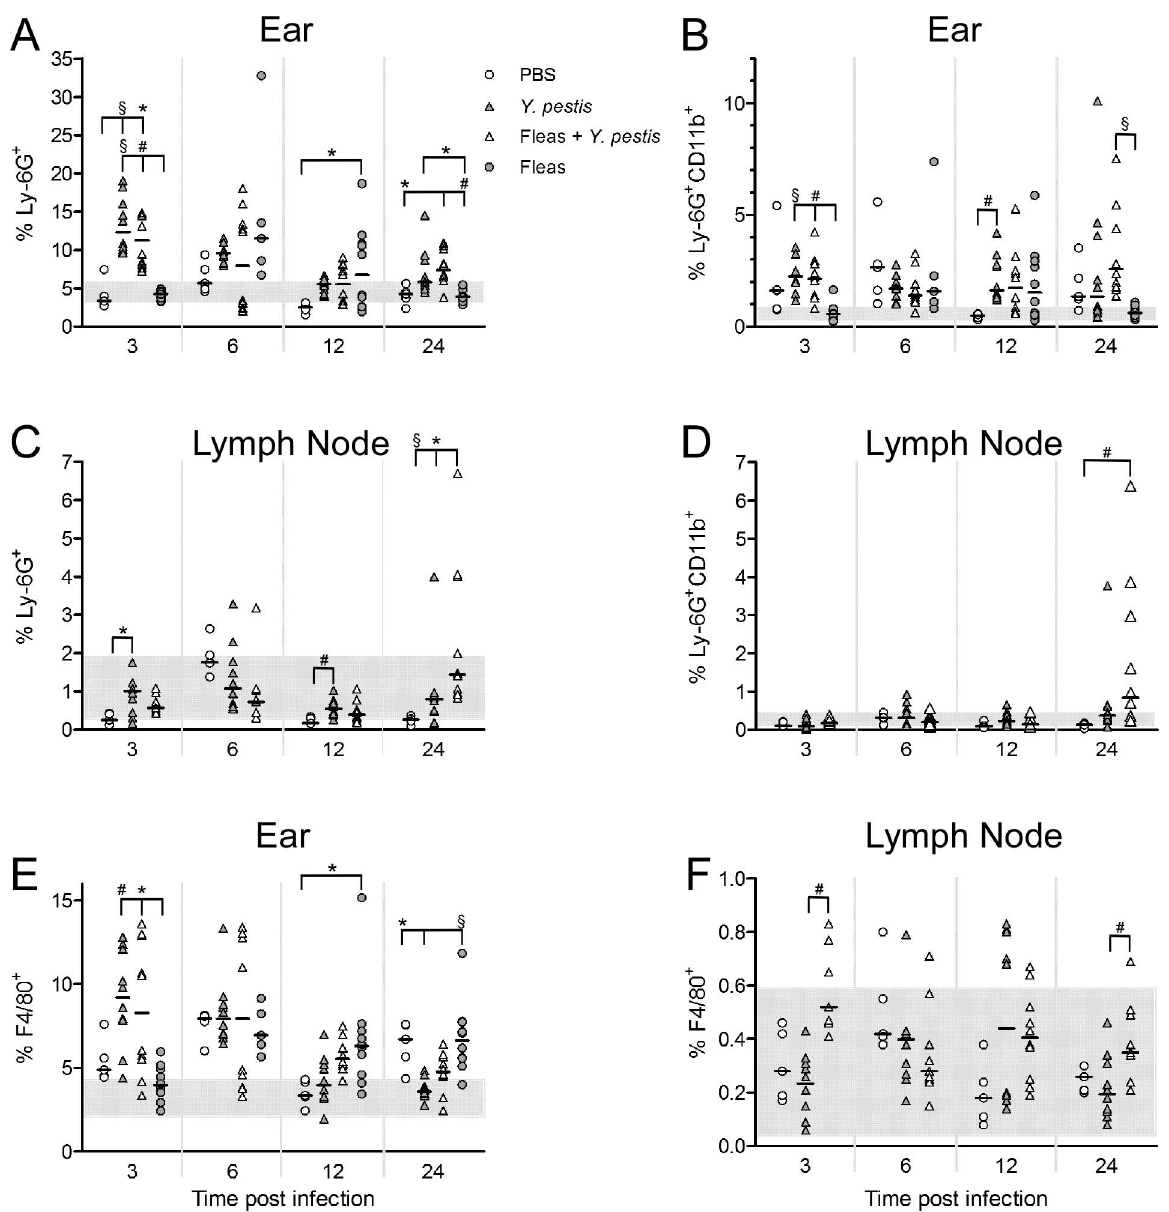
Figure 3. Timecourse of neutrophil and macrophage responses in the ear and draining lymph node of naı¨ve mice. Total neutrophils, expressed as the percentage of Ly-6G + cells out of all events counted ( A , C ); activated neutrophils, expressed as the percentage of Ly-6G + CD11b high cells out of all events counted ( B , D ); and total macrophages, expressed as the percentage of F4/80 + cells out of all events counted ( E , F ) in the ear and lymph node at different times after infection were determined by flow cytometry. The four different treatment groups are indicated; each symbol represents an individual. Horizontal bars indicate the median and the shaded area represents the range of values measured from a group of 6 uninjected control C57BL/6 mice. Median percentages were compared by Kruskal-Wallis nonparametric ANOVA followed by Dunn’s multiple comparison test. *, 0.01 , P , 0.05; # , 0.001 , P=0.01; 1 , P=0.001.